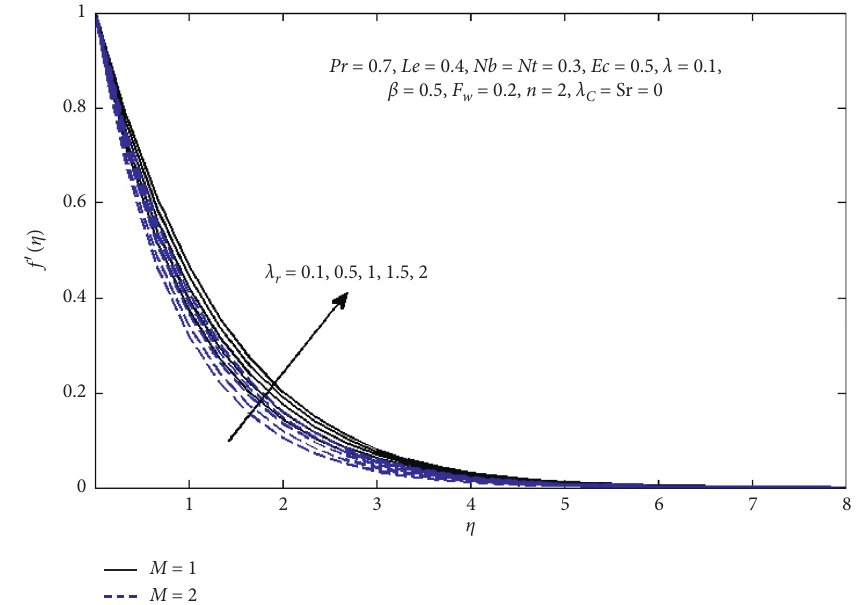
Figure 5: Variation of velocity f ′ concerning η with various values of λ